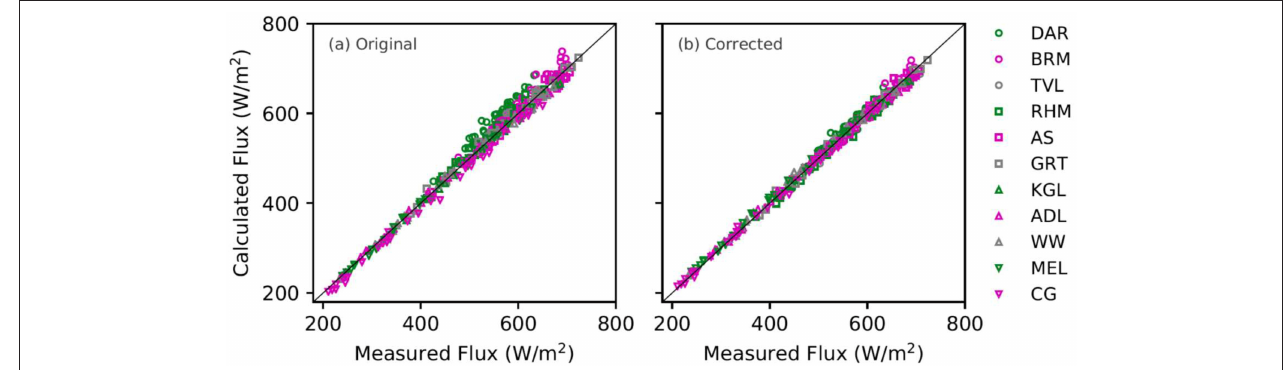
FIGURE 13 | Comparison of measured monthly mean solar flux with that calculated from the retrieved cloud properties, before applying the latitude-elevation corrections (a) and after the corrections (b)